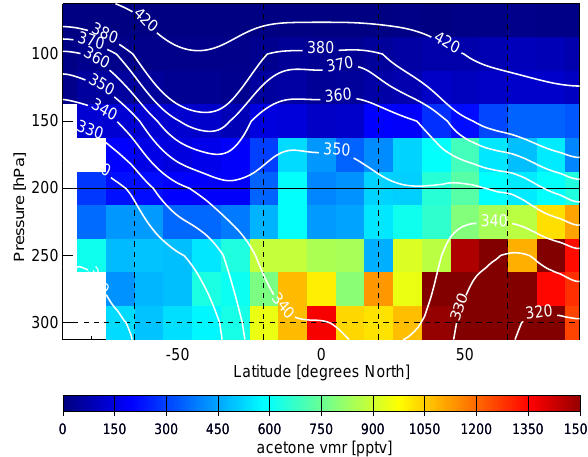
Fig. 13. 185 hPa MORSE acetone/150 hPa MOPITT CO ratio for August 2003 calculated from the 10 ◦ latitude x 20 ◦ longitude glob- ally gridded data (in units of pptv/ppbv). Ratios are only shown where more than ten cloud–free MIPAS data points exist in the box. Fig. 11. The zonal acetone distribution of acetone (units of pptv)